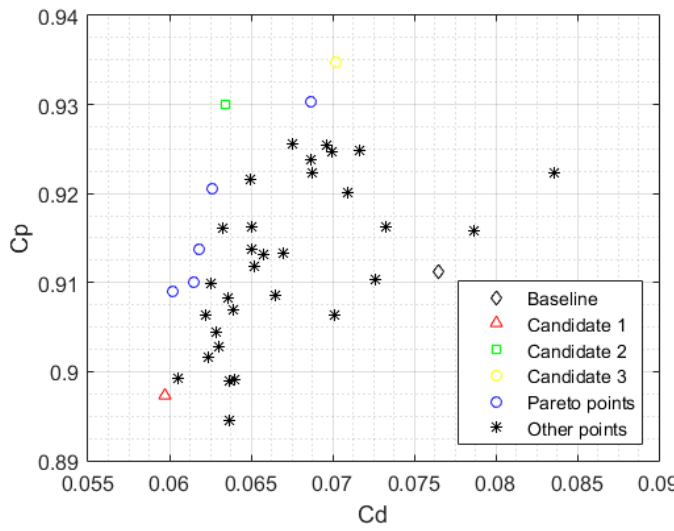
( b ) Figure 6. Optimization procedure: ( a ) general loop; ( b ) response surface update workflow. 3. Results and Discussion The final Pareto front is depicted in Figure 7, from which a subset of relevant configurations could be extracted: the baseline solution is marked with a black diamond, while the optimum C D , the